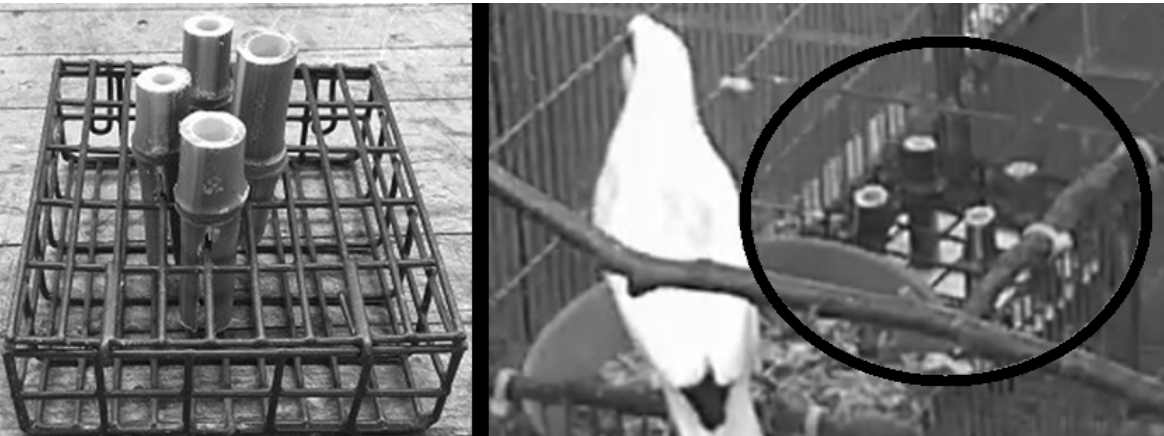
Figure 1. Examples of PCE item. Left: Prototype model, showing tubes in center cut to different lengths. Widths were standardized before use in project. Right: Footage from this project featuring PCE item (circled in black) placed on feeding platform. Tubes in corners are cut to length for difficulty level 2.